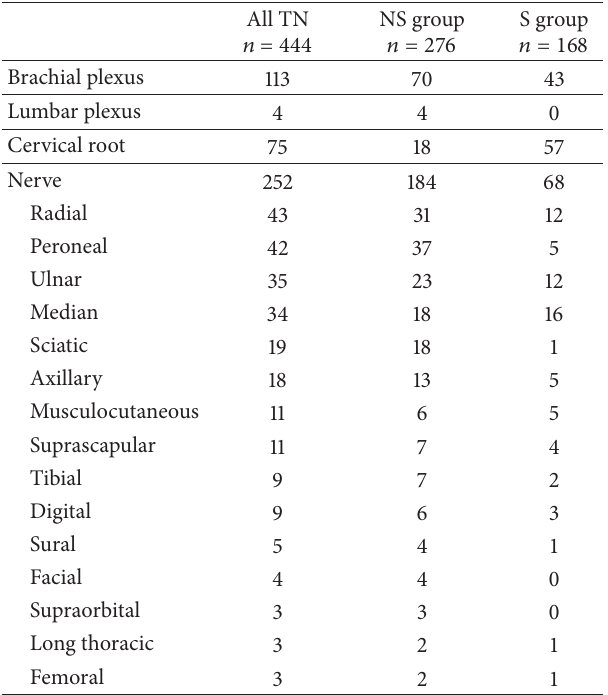
Table 2: Sites of